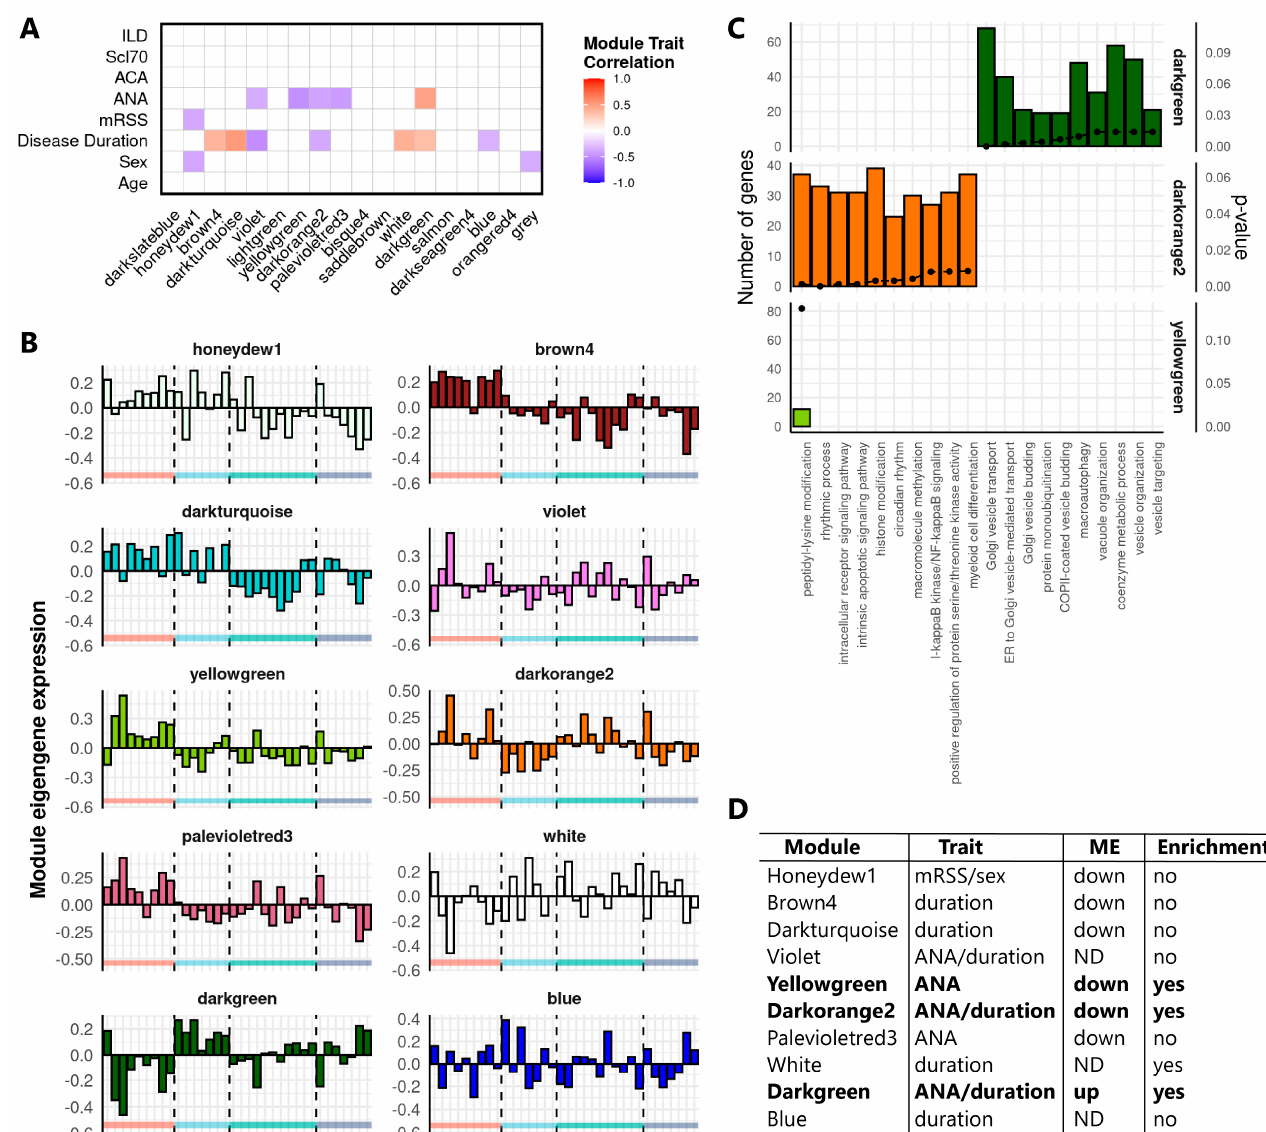
Figure 2. Identification and functional annotation of co-expression modules correlated with clinical traits in SSc. ( A ) Correlation of module eigengenes (MEs) to SSc clinical traits. Rows indicate the clinical traits, and columns indicate modules identified in the Definite cohort. Cells of significant correlations (Pearson, p -value < 0.05) are color-coded by the degree and direction of the correlation (red = positive; blue = negative). Abbreviations: mRSS, modified Rodnan Skin Score; ANA, antinuclear antibodies; ACA, anticentromere antibodies; Scl70, anti-topoisomerase I antibodies; ILD, interstitial lung disease. ( B ) ME expression (first principal component, y -axis) of modules significantly correlated with clinical traits. Bars represent individual donors grouped according to their disease subset represented by the colors on the x -axis (red = HC, light blue = ncSSc, green = lcSSc, dark blue = dcSSc). ( C ) GO-term enrichment analysis of selected modules. Top 10 enriched terms for each module are shown (B&H corrected p -value < 0.05). Bars depict the number of module genes associated to enriched GO terms, and dots represent the p -value for the enrichment. ( D ) Table indicating the characteristics for selected modules (Column 1), considering correlations to clinical traits (Column 2), distinct ME expression pattern versus heathy controls (Column 3, up = higher ME in SSc, down = lower ME in SSc, and ND = ME not distinct from healthy subjects), and functional enrichment (Column 4). Modules that were selected for subsequent analysis are highlighted in bold.